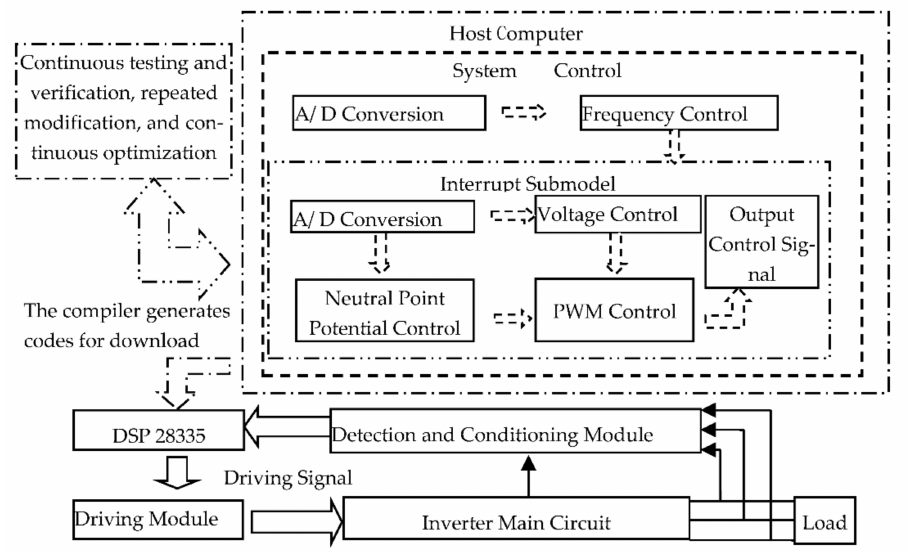
Figure 1. Model-based control design